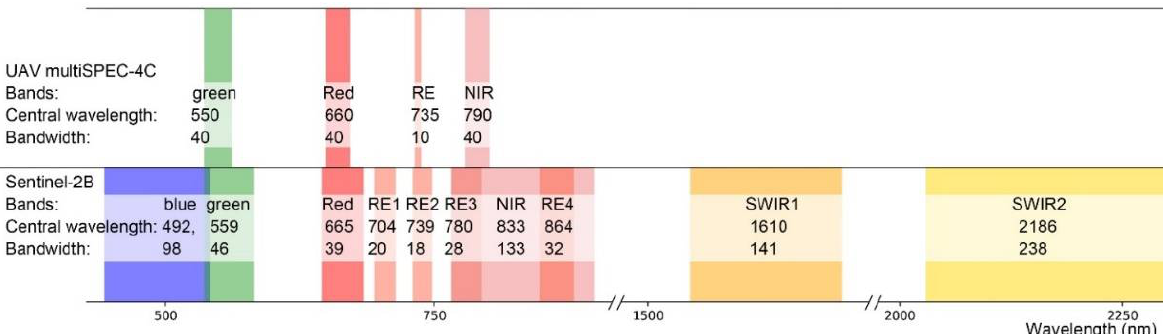
Figure 3. Central wavelengths and bandwidths of Sentinel-2B and multiSPEC-4C sensors.